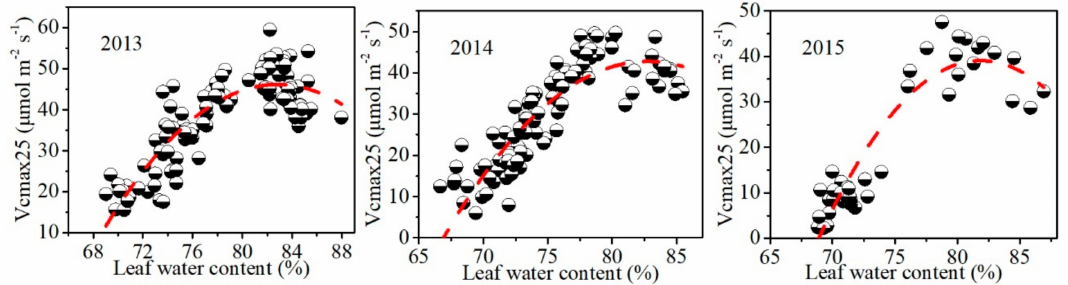
Figure 3. Relationship between LWC and Vcmax25 in 2013, 2014 and